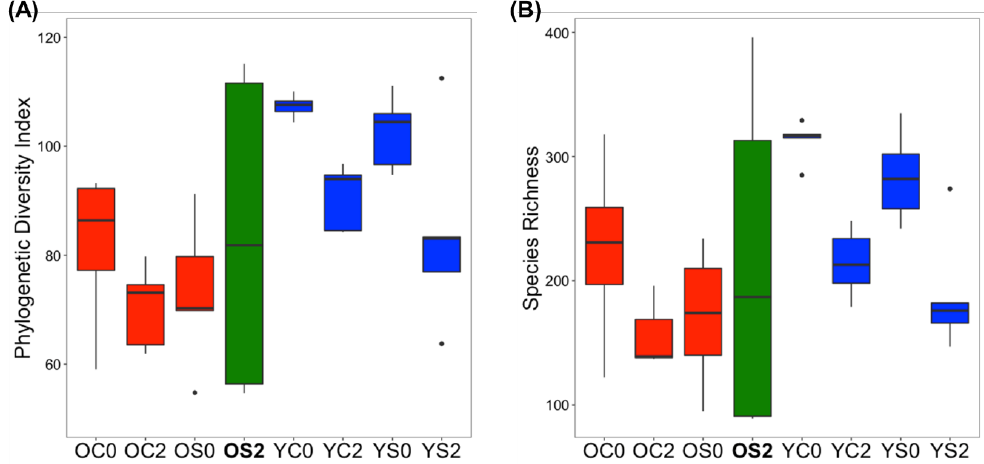
Figure 1. Alpha diversity in the di ff erent experimental groups. ( A ) phylogenetic diversity index, and ( B ) species richness. The boxes denote interquartile ranges (IQR) with the median as a black line and whiskers extending up to the most extreme points within 1.5 times IQR. Outliers are noted as points. Please note that O means Old and Y stands for Young; C means control diet and S indicates SFN diet; 0 means 0 months (immediately before diet administration) and 2 stands for 2 months after initiation of diet administration. Alpha diversity significance test results are summarized in Table